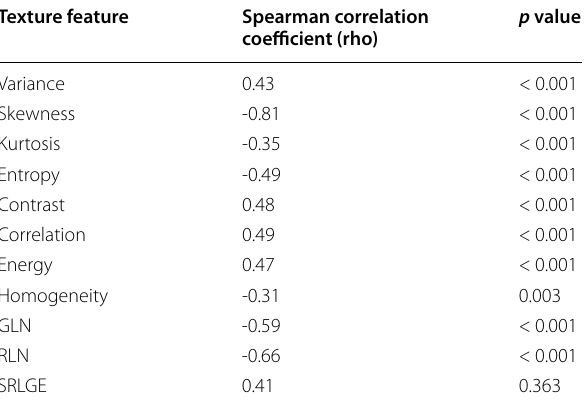
Table 3 Spearman’s correlation coefficient and p values for each texture feature and breast density